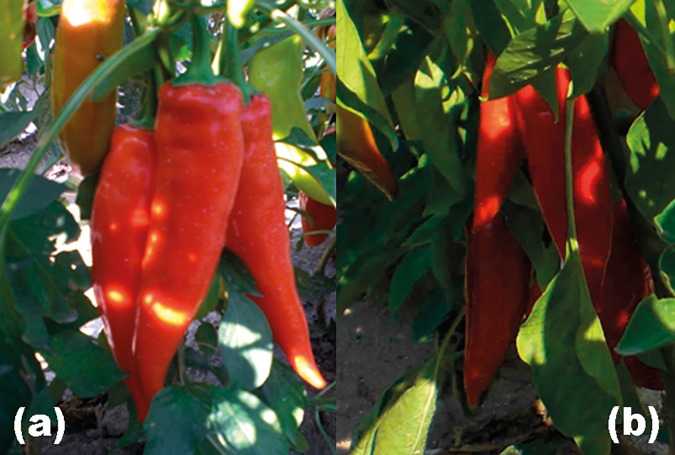
Pepper genotypes with fruit in technical and botanical maturity phase.a) M38 with orange colour of mature fruit; b) P31 with red colour of mature fruit.